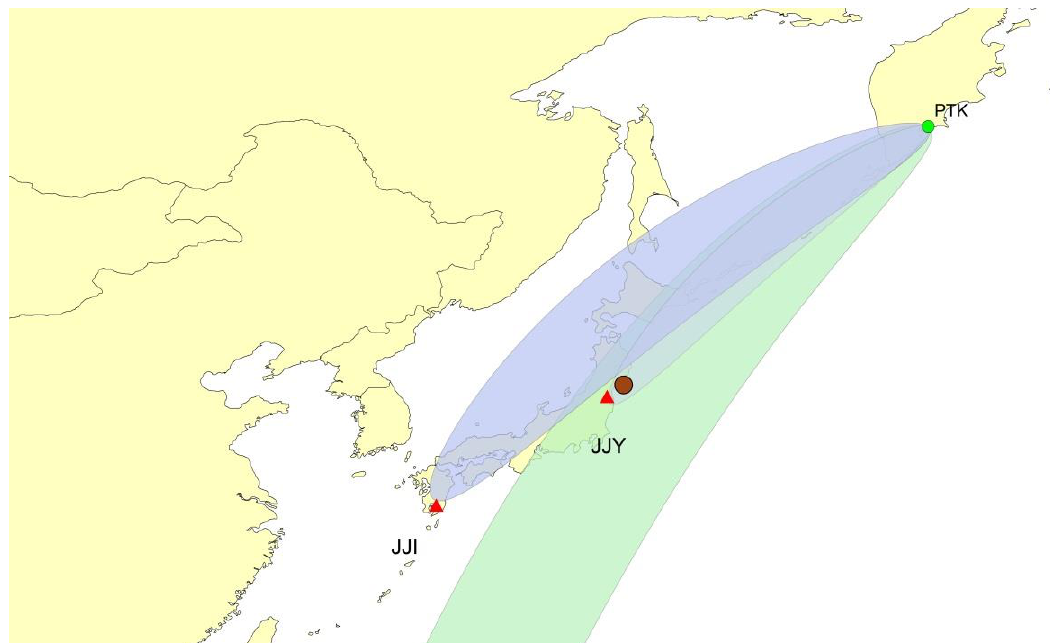
Figure 2. Locations of a VLF/LF observing station (PTK in Kamchatka) and VLF/LF transmitters of JJY and JJI (in Japan), together with the corresponding wave sensitive (Fresnel) zone for each propagation path, including an additional transmitter of NWC (Australia). Only the second EQ epicenter is also plotted.